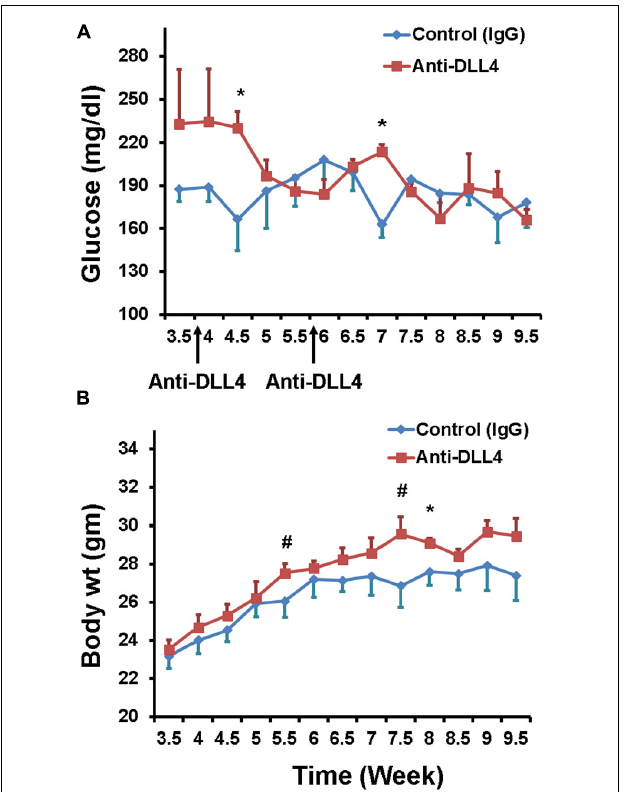
FIGURE 1 | Glycemic effects of anti-DLL4. (A) Weekly fasting blood glucose in anti-DLL4 and control IgG treated groups ( n = 4 per group). (B) Weekly body weight in anti-DLL4 and control IgG treated groups ( n = 4 per group). Statistical significance was determined at P < 0.05(*), means with different superscript (#) have an approaching significant difference ( P = 0.06 to P < 0.1) between the